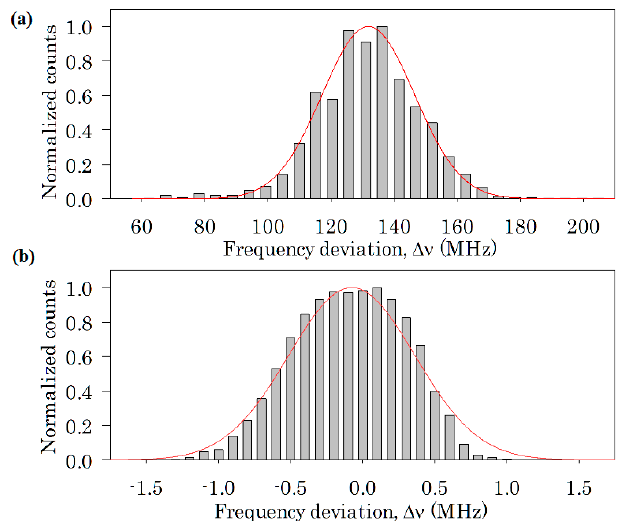
Figure 2. The histograms of frequency deviation from 30-min beat-wave signal recording by a radio frequency (RF) spectrum analyzer. The solid red line is fitting curve based on Gaussian distribution ( a ) without cavity stabilization. The frequency deviation centers at 131.8 MHz with a 14.7-MHz standard deviation; ( b ) with cavity stabilized feedback circuit functioning properly. The center is at −76 kHz with a 437-kHz standard